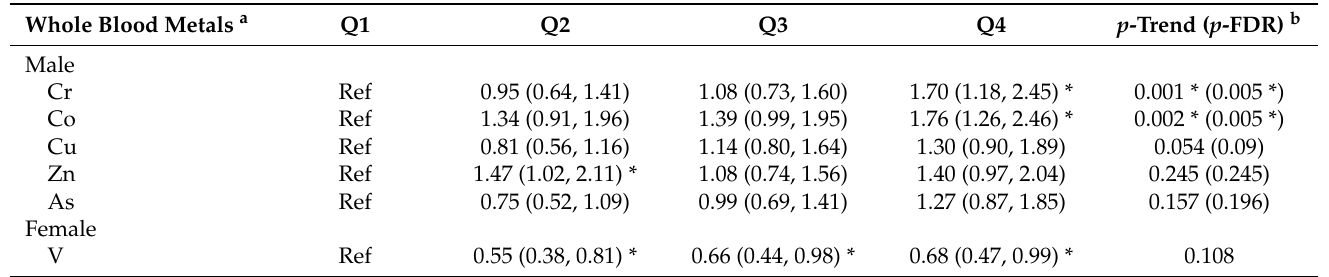
Figure 1. Single-metal logistic regression model for the associations of blood metal quartiles with hyperuricemia. Model is adjusted for age, education level, residence area, smoking status, alcohol use, physical activity, sitting time, BMI, diabetes mellitus, hypertension, TC, and TGs. p -trend across quartiles of metals are obtained by including the median of each quartile (natural log-transformed) as a continuous variable in the single-metals model. FDR corrections are performed to adjust for multiple tests. * p < 0.05. Table 2. Multiple-metal logistic regression model for the associations of blood metal quartiles with